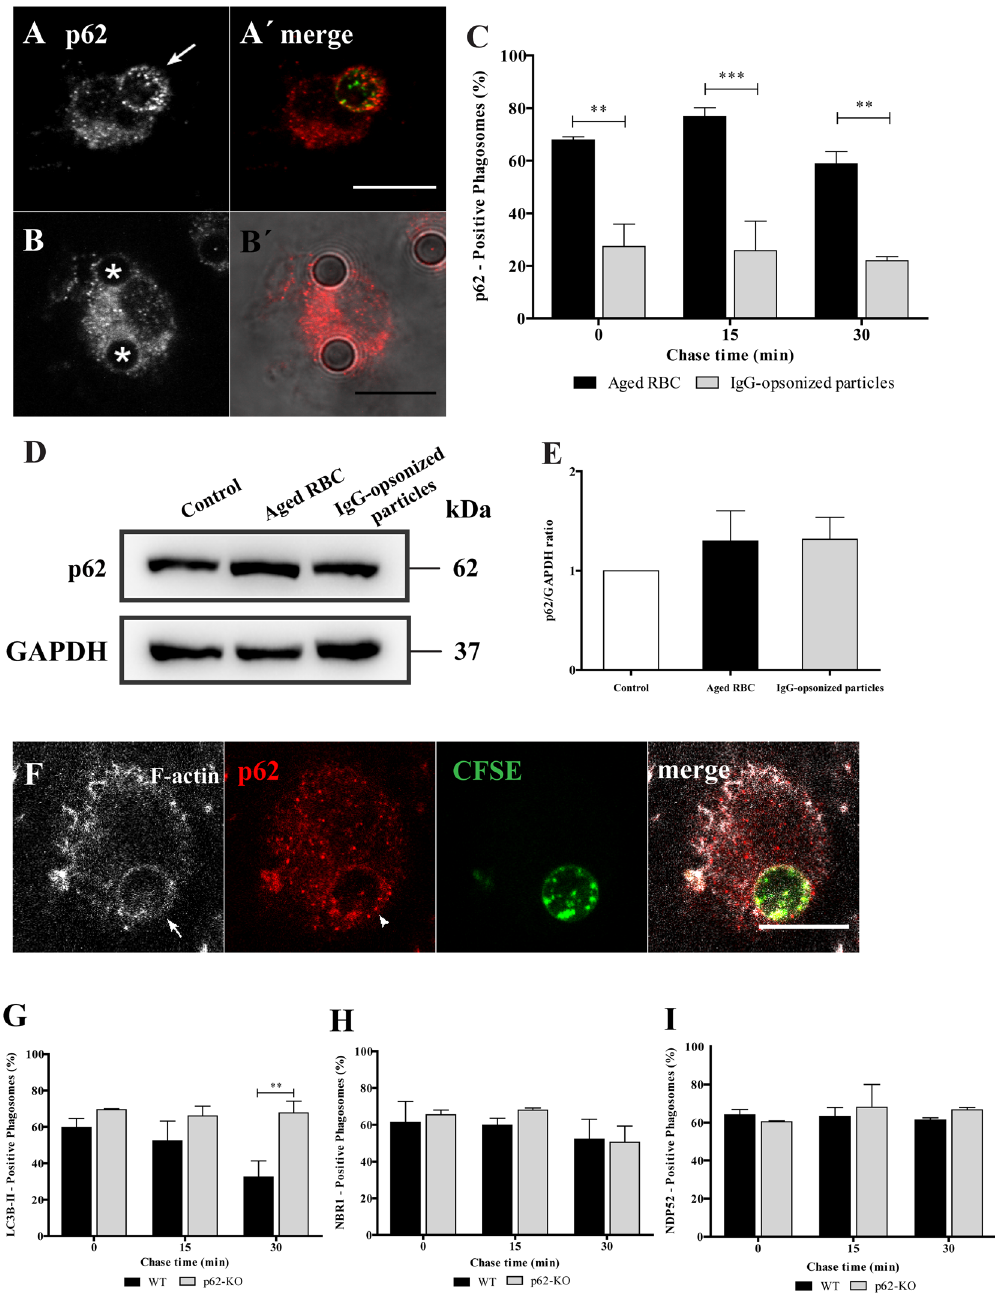
Figure 5. Effect of p62 in the recruitment of LC3B-II, NBR1 and NDP52 to phagosomes containing RBC cells in BMDM. After pulse-chase experiments with RBC or IgG-opsonized particles, WT-BMDM cells were fixed and stained for p62. ( A ) WT-BMDM containing a p62-positive phagosome at 15 min chase time. (A ′ ) Corresponding merged image showing the internalized RBC stained with CFSE. ( B ) WT-BMDM containing p62-negative phagosomes at 15 min chase time. (B ′ ) Corresponding merged image showing the internalized IgG-opsonized particles in DIC. ( C ) Quantification of p62 positive-phagosomes. ( D ) p62 levels in total cell lysates of WT-BMDM exposed for 15 min to RBC or IgG-opsonized particles. GAPDH was used as loading control. ( E ) Ratio of p62/GAPDH of quantified bands in cells exposed or not to RBC, IgG-opsonized particles. Three independent experiments were performed. ( F ) Representative image of RBC-containing phagosome positive for actin (in white) and p62 (in red). Arrow and arrowhead indicate actin- and p62-positive phagosome, respectively. Quantification of LC3B-II- ( G ), NBR1- ( H ) and NDP52- ( I ) positive phagosomes in WT- BMDM (black bars) and p62-KO- BMDM (grey bars). The values are means ± SEM of, at least, three independent experiments. At each time point, at least, 50 phagosomes were analyzed. ** p < 0.01; *** p < 0.001 comparing differences between p62-positive phagosomes containing RBC and IgG-opsonized particles or differences between of LC3B-II-positive phagosomes in WT- and